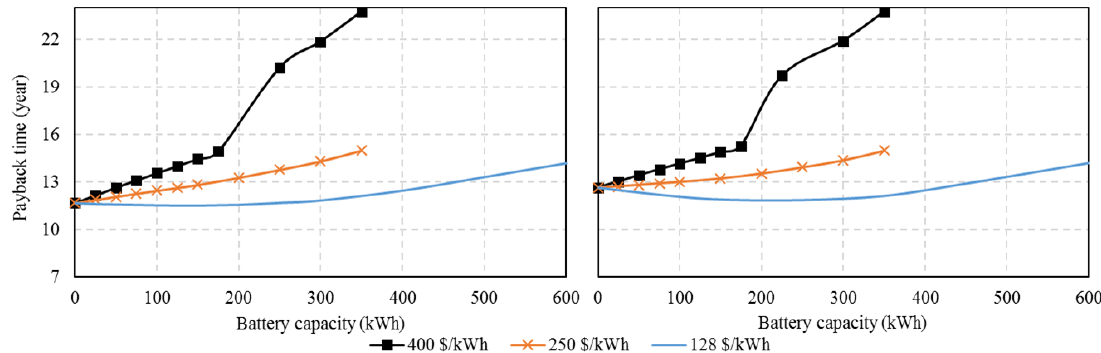
Figure 10. The effect of the battery capacity on the payback time of the PV system for feed-in tariff =6.7 ₵ /kWh ( left ), and 3.35 ₵ /kWh ( right ). Annual saving target 50%.